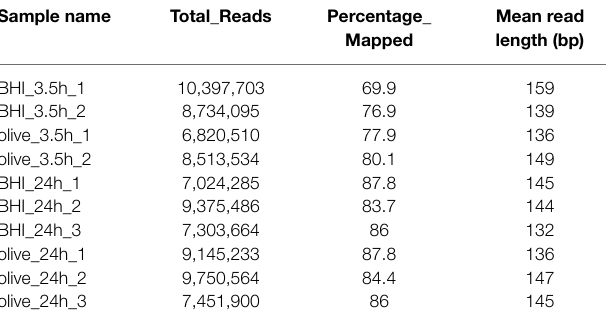
TABLE 1 | Overall quality of RNA-Seq